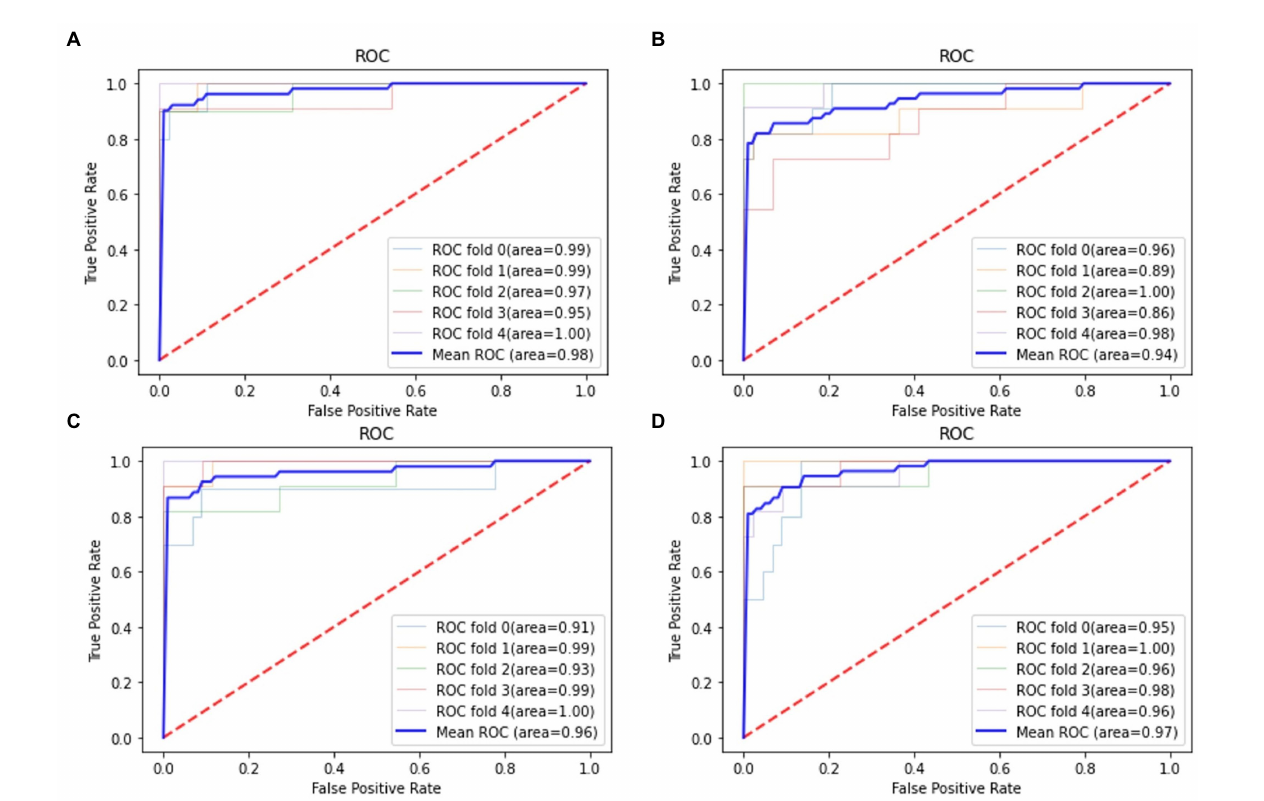
FIGURE 5 Receiver operation characteristics (ROC) curves for AD classification in the training set. (A) Support vector machine (SVM) classifier; (B) RF classifier; (C) GNB classifier; (D) Adaboost